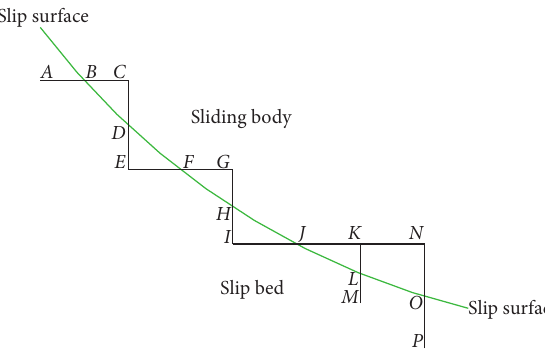
Figure 3: One ASCL in a landslide. The zone above the sliding zone is a sliding body while the zone below the sliding zone is a slip bed. Assuming a slip surface as a boundary in the ASCL, the ASCL is disintegrated into the section above the slip surface and the section below the slip surface. The ends of the antislide members and the intersection on the slip surface are numbered in English